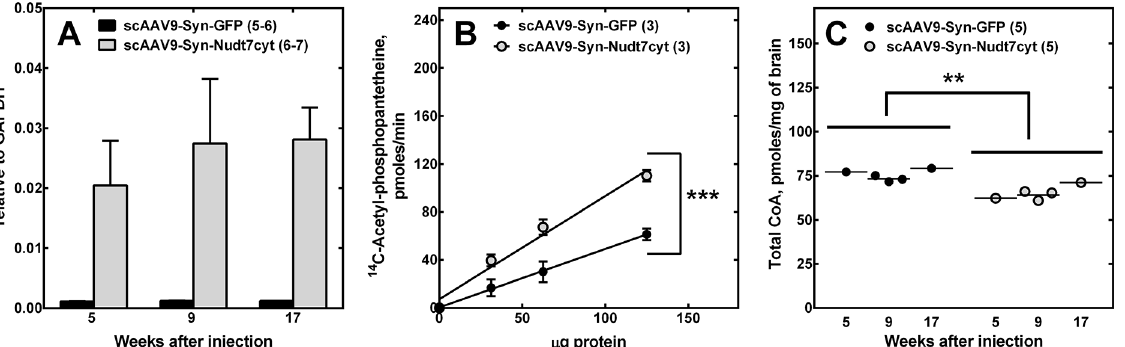
PLOS ONE | DOI:10.1371/journal.pone.0130013 June 8,